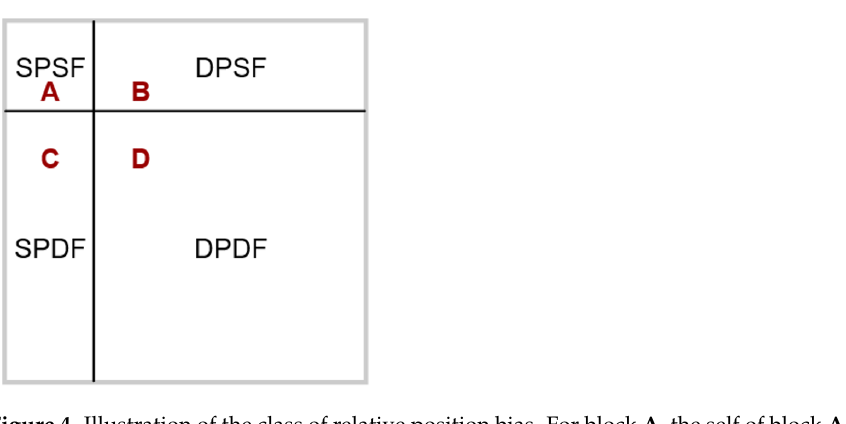
Figure 4. Illustration of the class of relative position bias. For block A , the self of block A is class SPSF, block B in the same row is class DPSF, block C in the same column is class SPDF and block D in the rest of window is class